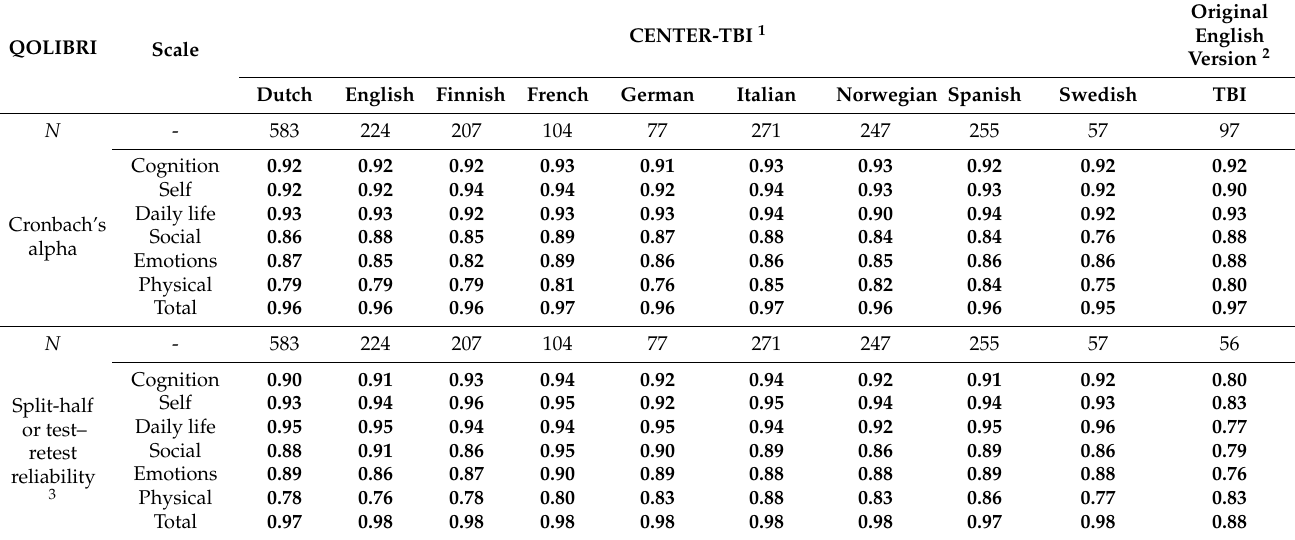
Table 5. Reliability of the QOLIBRI: Comparison of the CENTER-TBI results with the values from the original English validation study in the field of